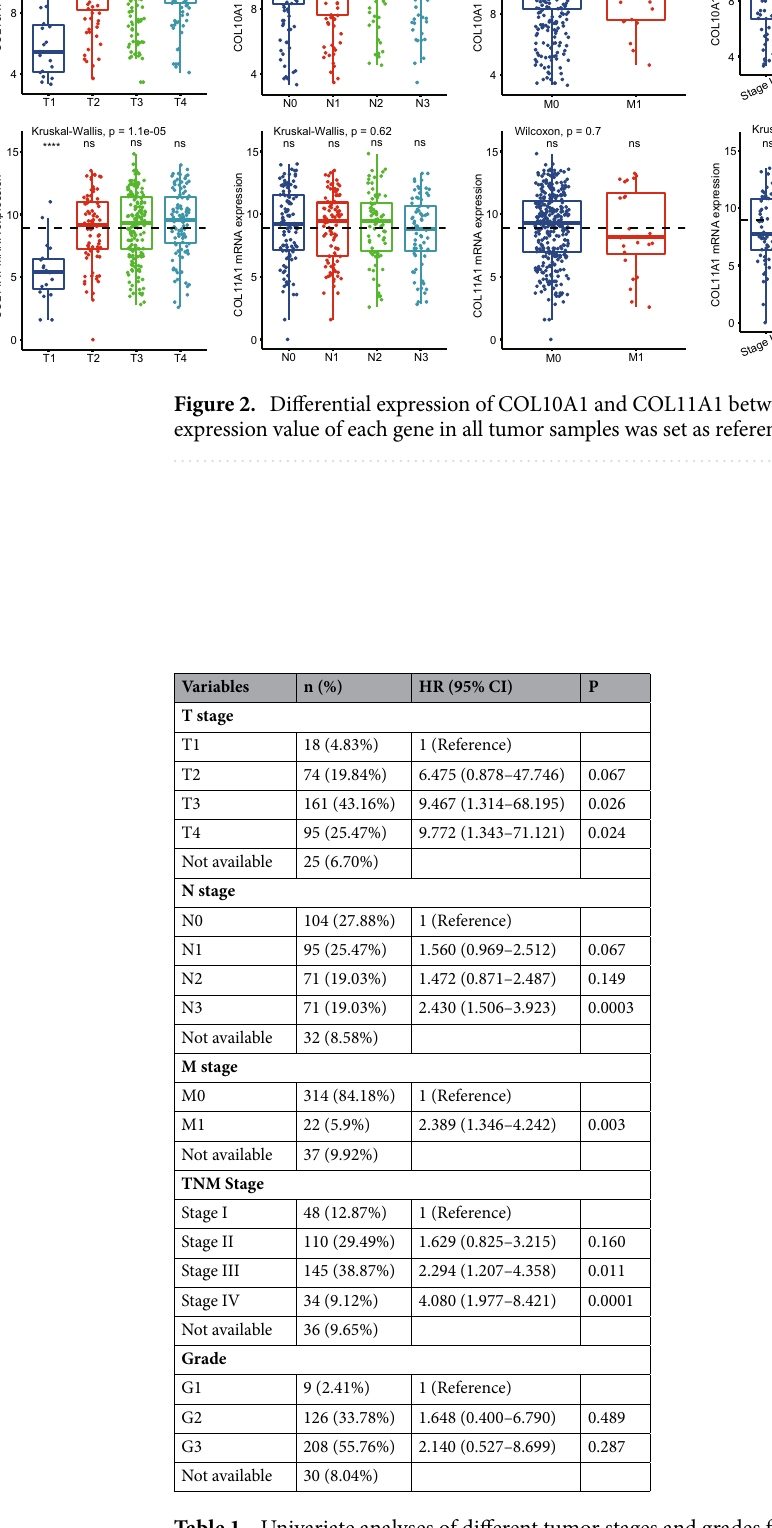
Table 1. Univariate analyses of different tumor stages and grades for OS in GC